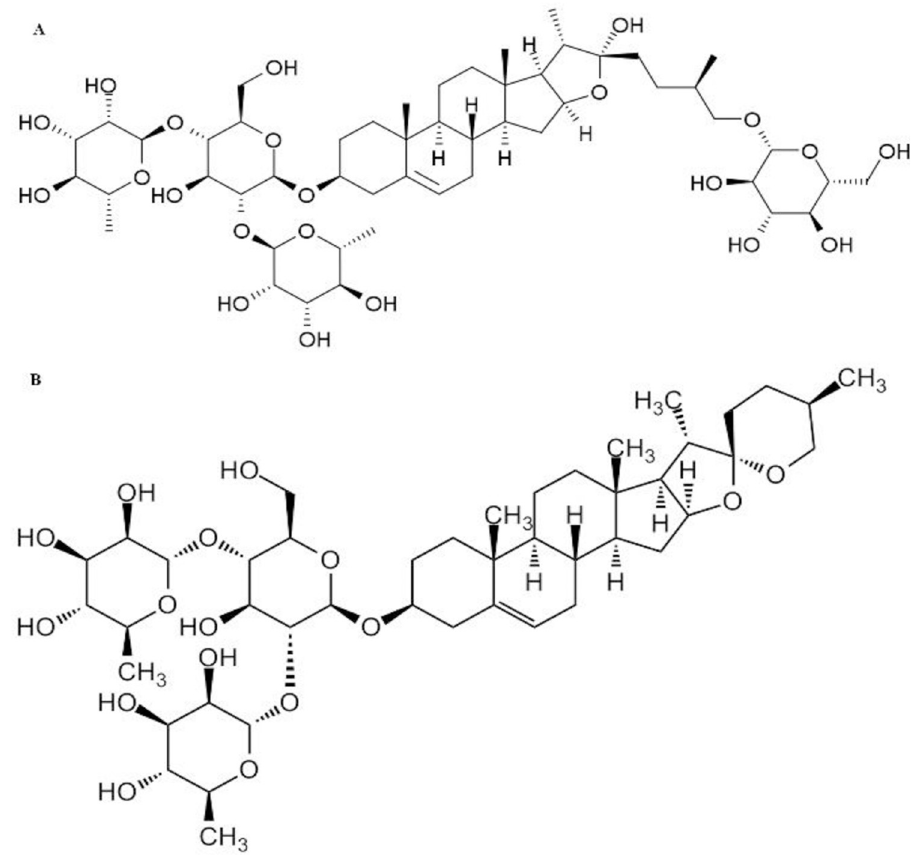
Fig 1. Chemical structures of protodioscin (A) and dioscin